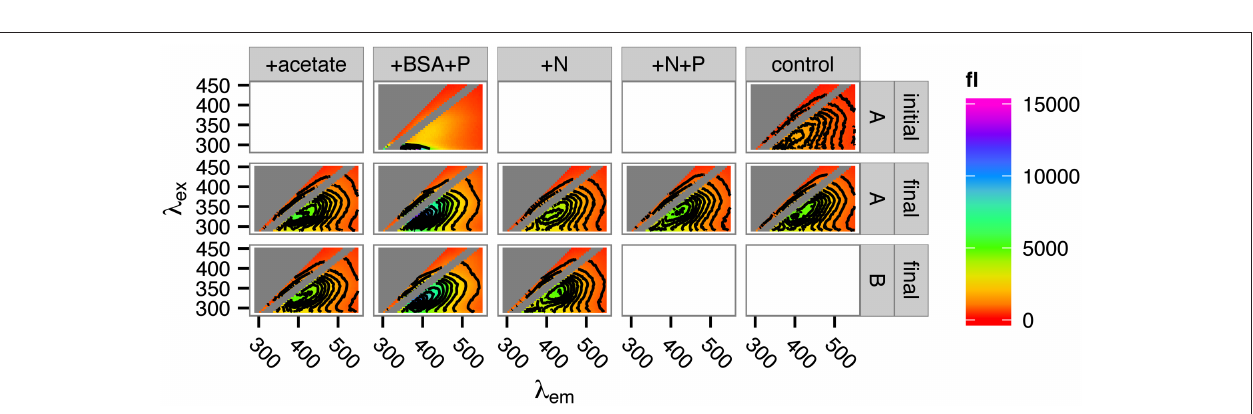
FIGURE 6 | Fluorescence spectra of incubation DOM at the start and at the end of the incubations. Top row: spectra of the +BSA+P treatment and the control treatment at time zero (“initial”). Middle and bottom rows: replicate spectra after 57 days incubation (“final”). Insufficient sample remained for duplicate measurement of the +N+P and control samples after 57 days. “A” and “B” in the right-side panel labeled refer to incubation